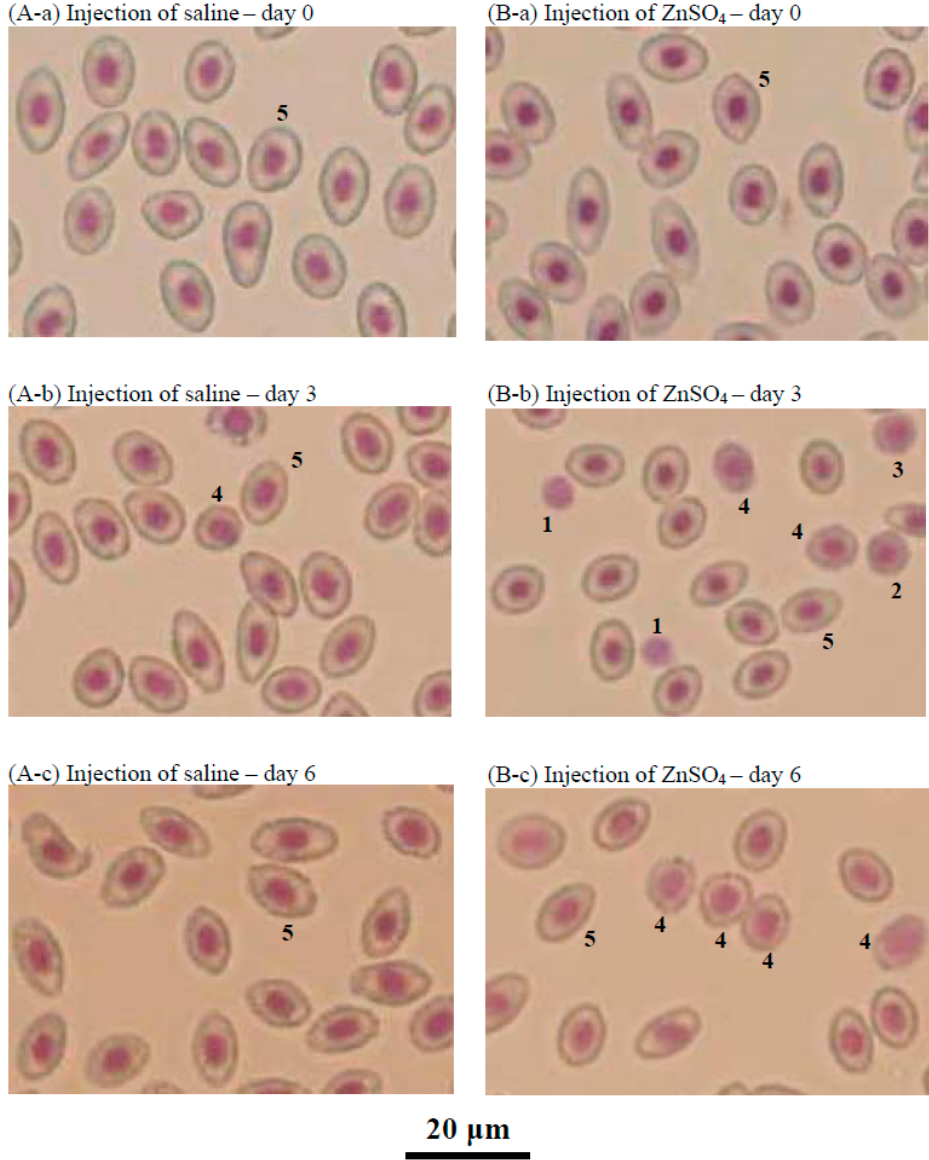
Figure 7. Giemsa staining of the blood cells sampled from tilapia subjected to blood loss and injected with saline ( A ) or ZnSO 4 ( B ). At day zero, approximately 95% of the blood cells were stage 5 RBCs, erythrocytes ( A - a , B - a ). At day three and day six, the blood cell composition of the fish injected with saline ( A - b , A - c ) was similar to that on day zero; that is, approximately 95% stage 5 RBCs and 3% stage 4 RBCs (orthochromatic erythroblasts). However, for fish injected with ZnSO 4 , newly proliferated cells were observed on day three ( B - b ), such as stage 1 RBCs (lymphoid hemoblasts), stage 2 RBCs (early erythroblasts), and stage 3 RBCs (polychromatophilic erythroblasts). At day six, the blood cells from the fish injected with ZnSO 4 included more stage 4 RBCs (orthochromatic erythroblasts) ( B - c ).